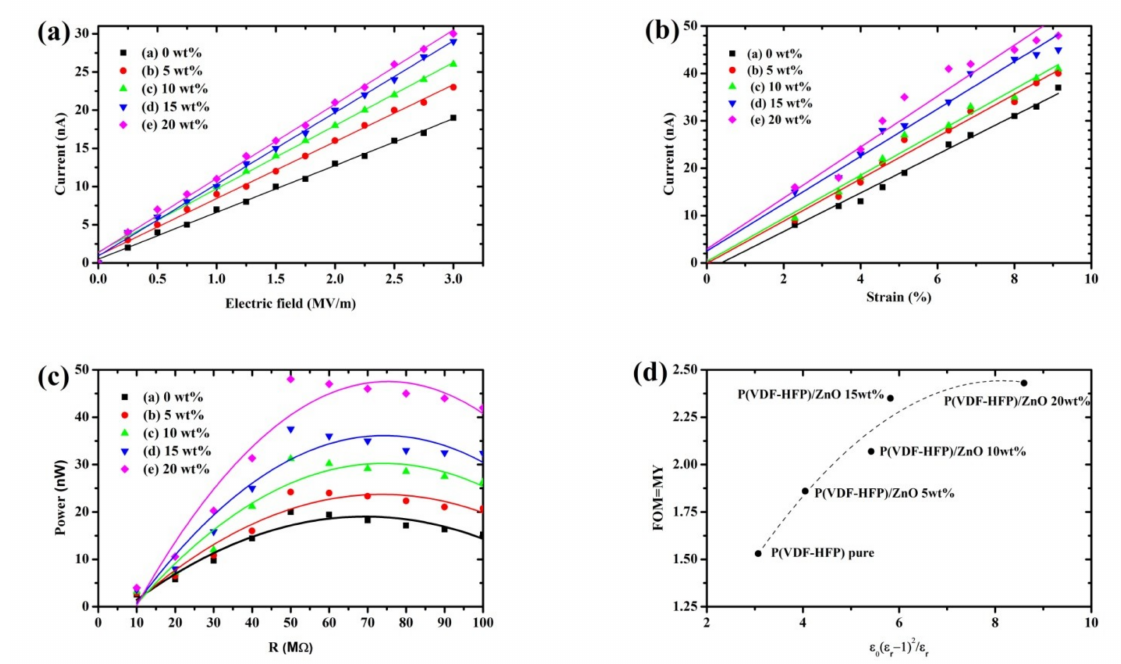
Figure 11. ( a ) The output current as a function of the electric field at 5% strain; ( b ) the output current as a function of %strain at E = 3 MV/m; ( c ) the variation of the electric power output as a function of load resistance at E = 3 MV/m; and ( d ) the figure of merit (FOM) as a function of ε 0 ( ε r − 1 ) 2 / ε r for all samples at 20 Hz.